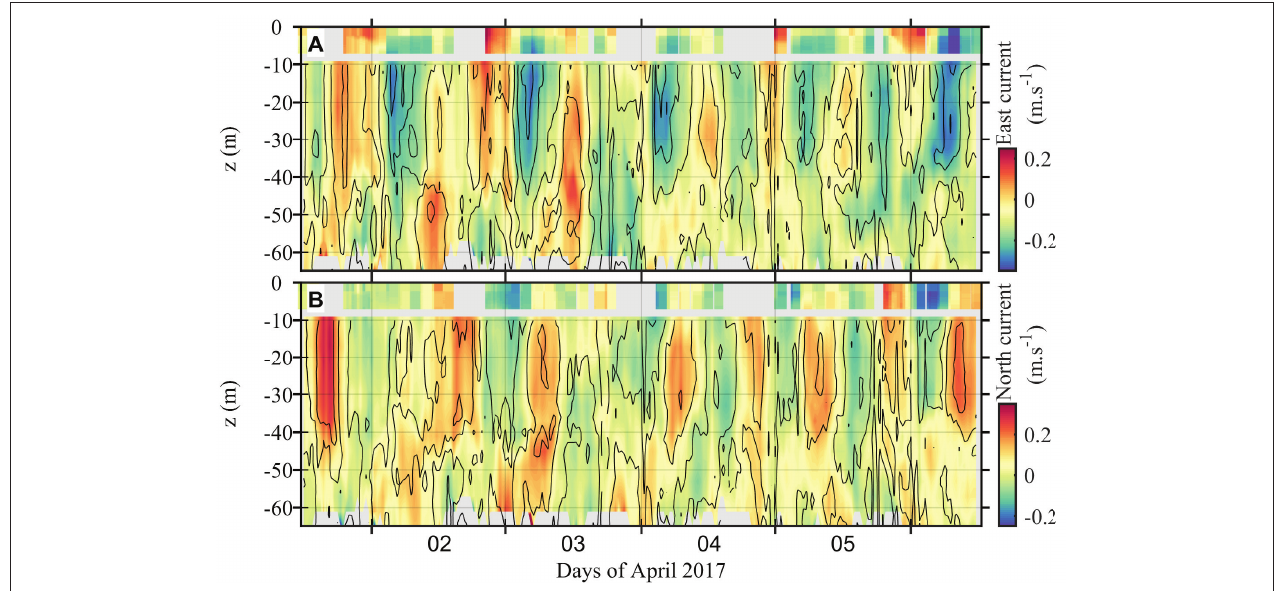
FIGURE 5 | (A) East current and (B) north current components measured by the SV2 Wave Glider Kelvin (colormap) and the R/V Sally Ride (black contours) during LCDRI2017. Current above 6 m depth was measured by the upward-looking 5-beam Nortek Signature 1000 ADCP, while current below this depth was measured by the downward-looking Teledyne RDI Workhorse 600 kHz ADCP. The shallowest measurements (at 5.08 m depth) from the RDI ADCP were removed because they were contaminated by side-lobe reflections due to the sub fins. Direct comparison of the 30 min averaged current components between the downward-looking ADCPs from the two platforms gives a coefficient of determination r 2 0.70 when comparing currents measured at depths in the 9.6–60.6 m depth range. =